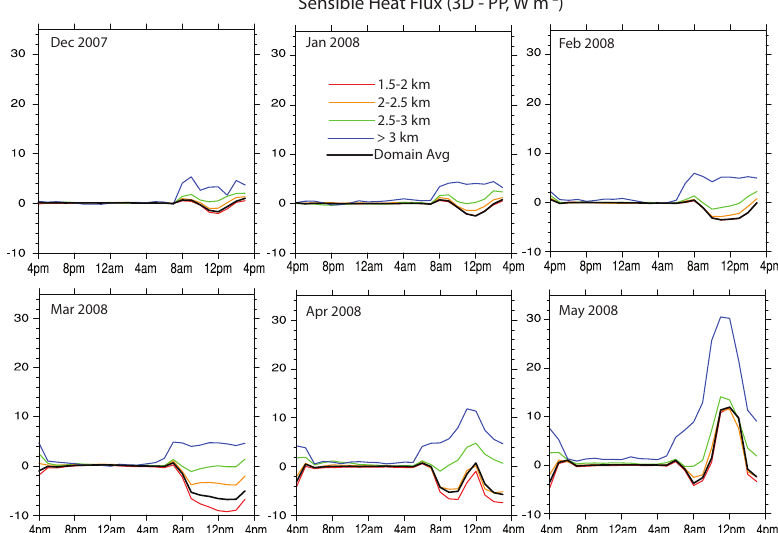
Fig. 6. Same as in Fig. 5, except for the monthly mean domain-averaged diurnal variation time series of sensible heat